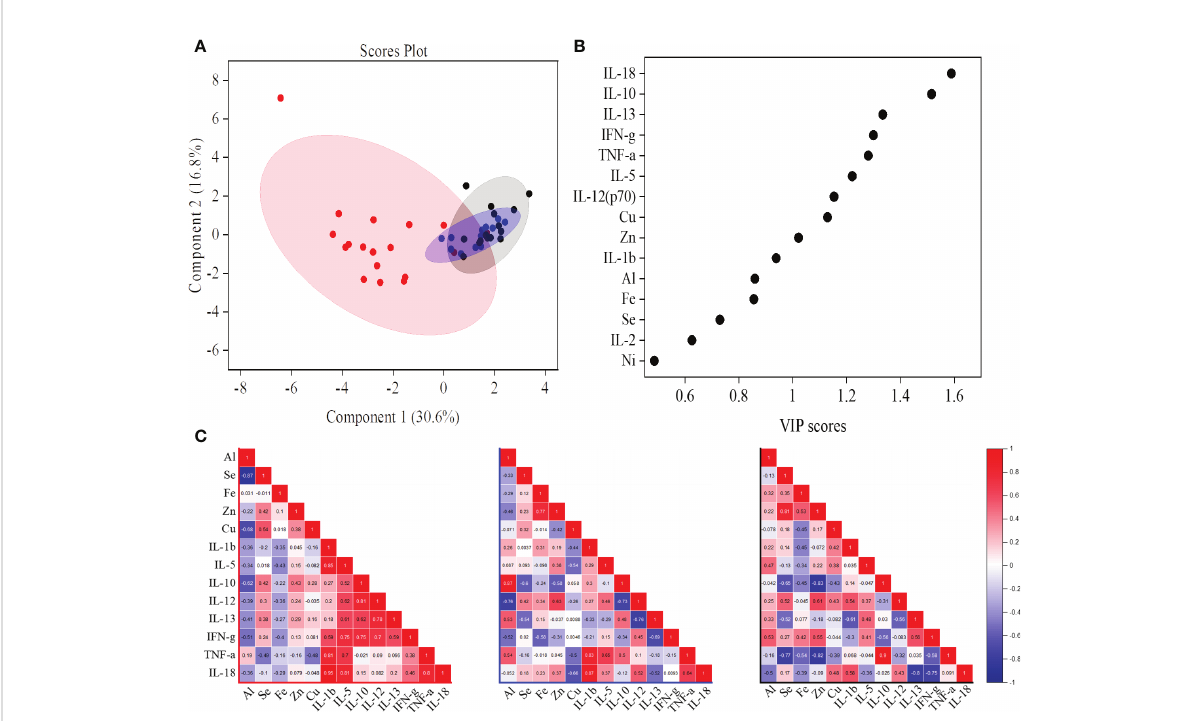
FIGURE 5 A partial least squares discriminant analysis (PLS-DA) model of identi fi ed serum cytokines and trace metals showed the active tuberculosis (ATB) study group cluster away from non-tuberculosis (NTB) and healthy control subjects (A) . Important cytokines and trace metals identi fi ed based on the variable importance in projection (VIP) score from the PLS-DA model (B) . Correlation (Pearson r ) values between important markers [common molecules from VIP score and analysis of variance (ANOVA)] in ATB, NTB, and healthy study groups (C)